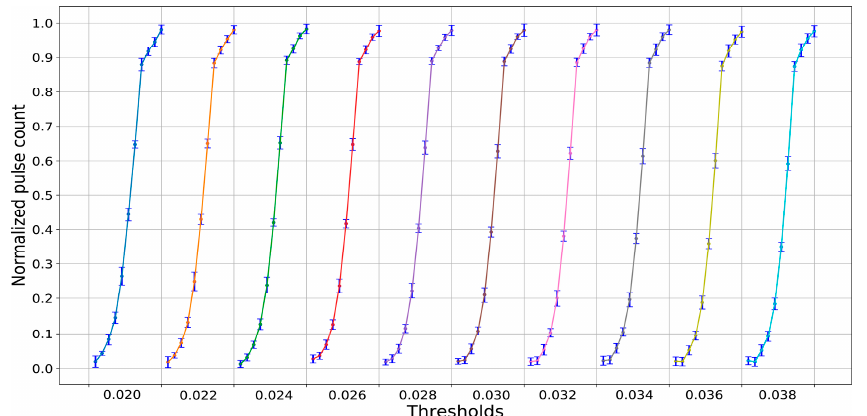
Figure 8. Diagram of the standard deviation of the pulse count feature with different thresholds.